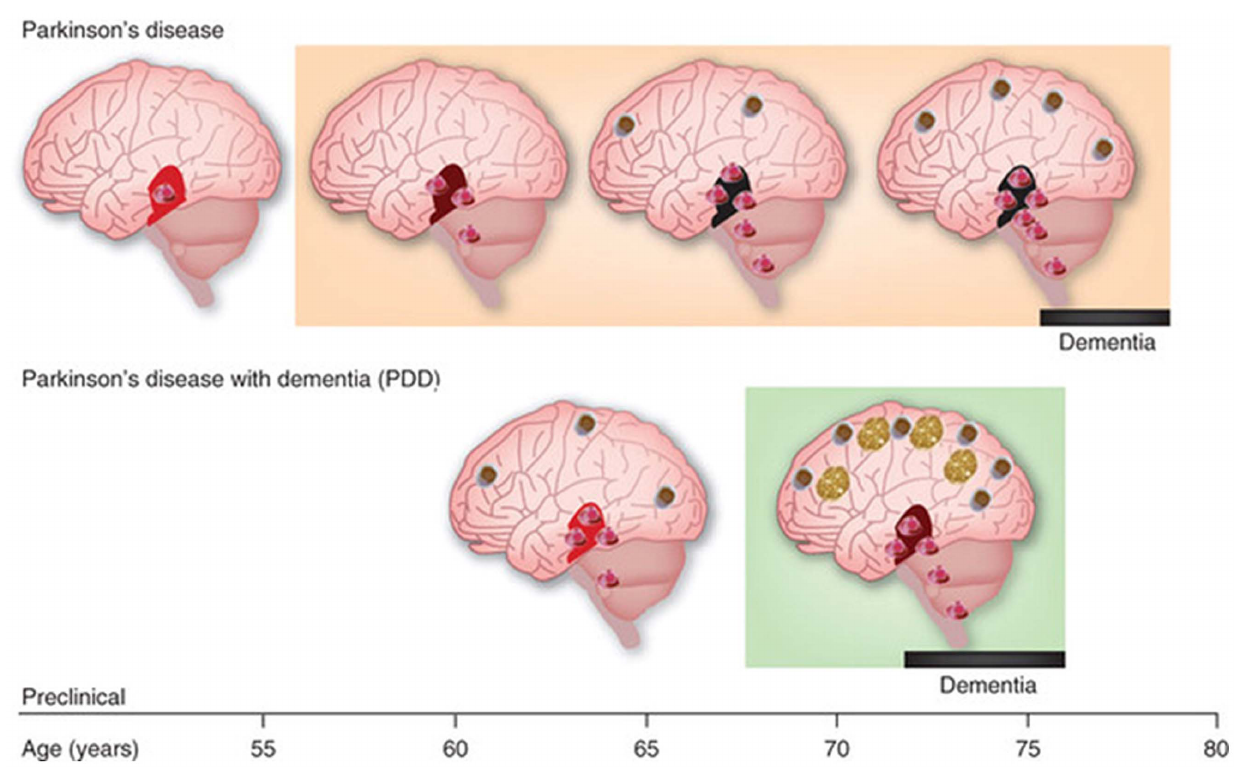
Figure 3. Examples of sub-types of Parkinson’s disease as a function of site of Lewy Bodies (LB) appearance in sub-cortical and cortical structures, density of LB and time course of spread. In all cases the presence of LB eventually leads to various stages of dementia and various subtypes of PD.